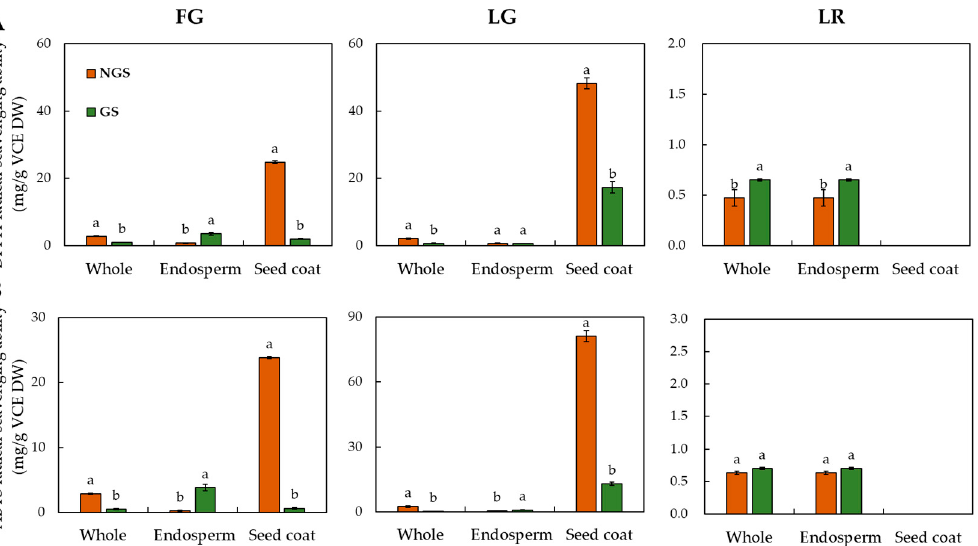
Figure 4. Changes in ( A ) DPPH and ( B ) ABTS radical scavenging ability of different cultivars of lentils during germination. Different letters indicate the significant difference in Tukey’s studen- tized test at p < 0.05. test at p <